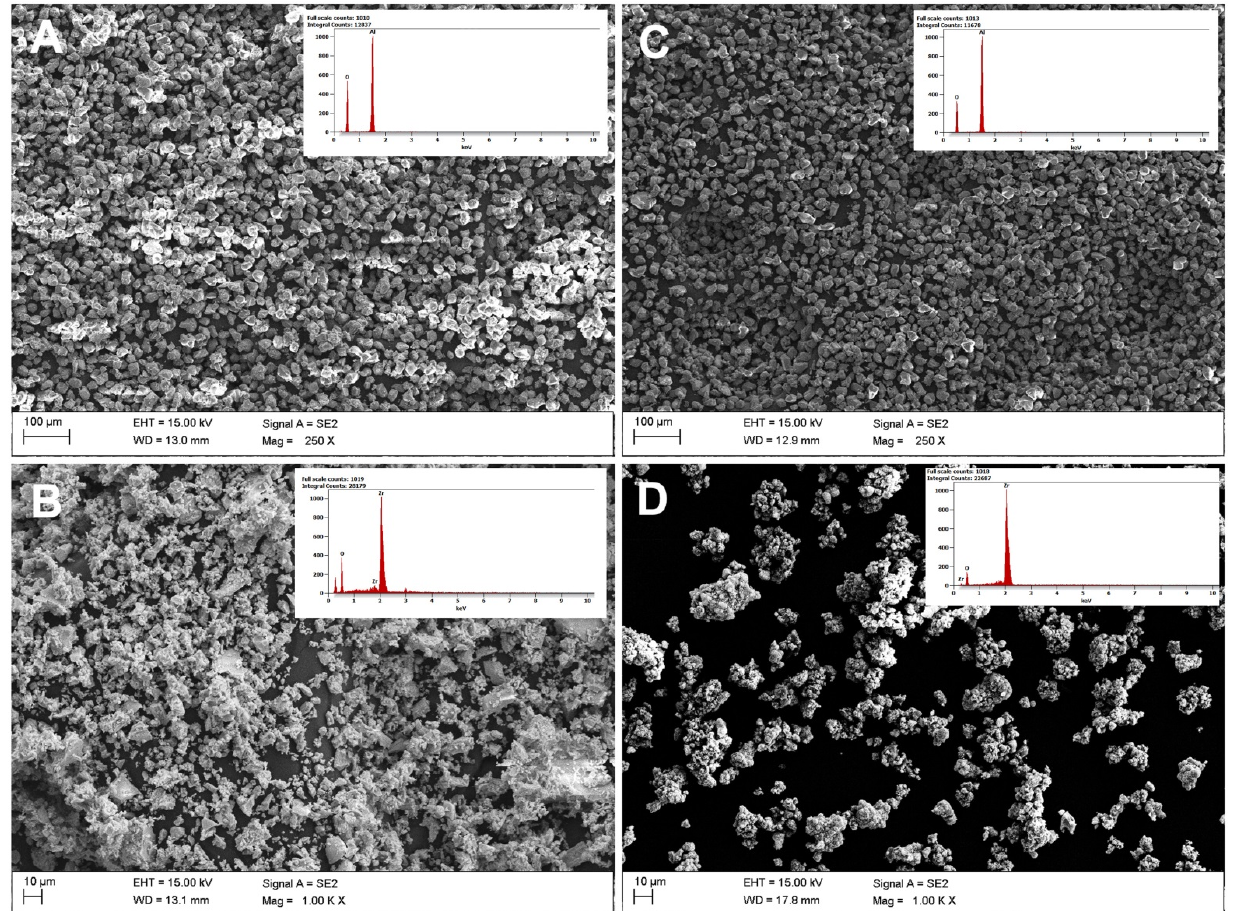
Figure 5. SEM/EDS micrographs of the powders: ( A ) raw alumina, ( C ) alumina after etching in Piranha Solution; ( B ) raw zirconia, ( D ) zirconia after etching in Piranha Solution.